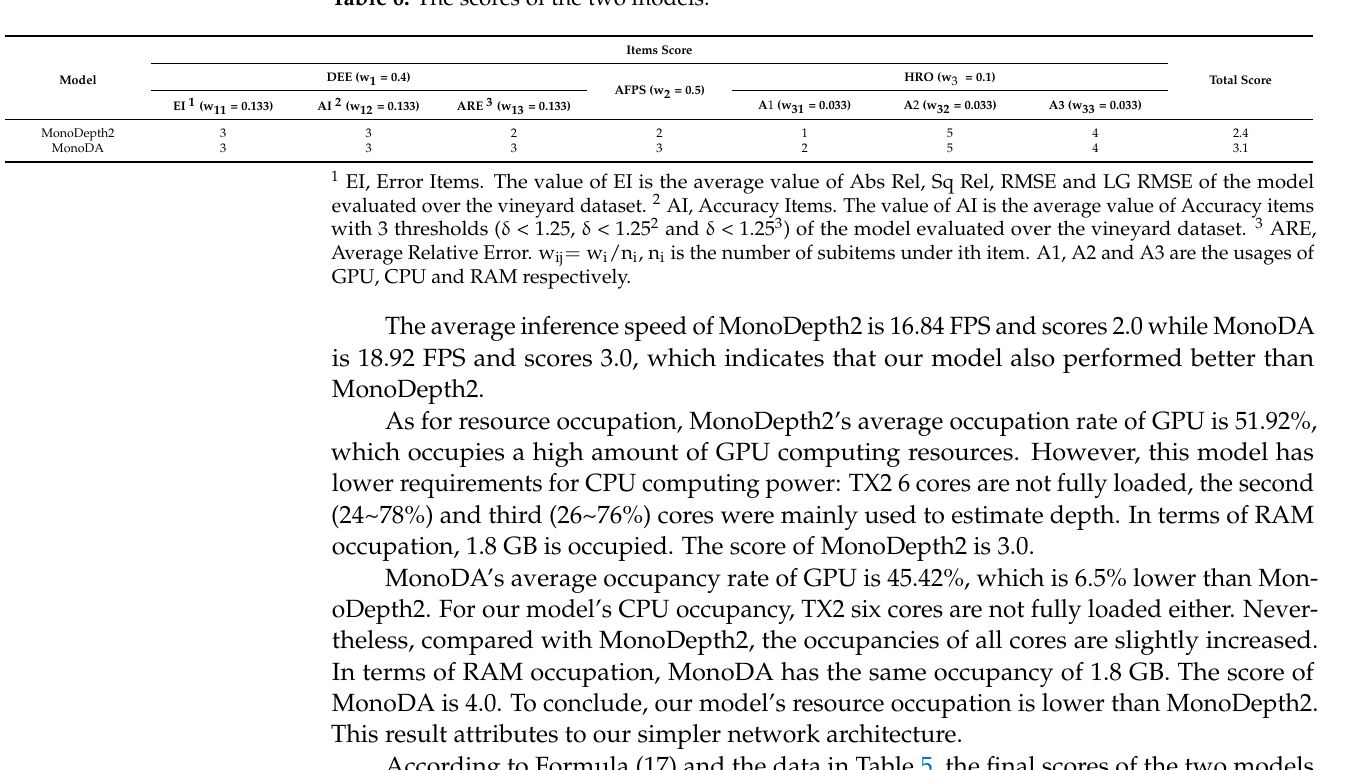
Table 6. The scores of the two